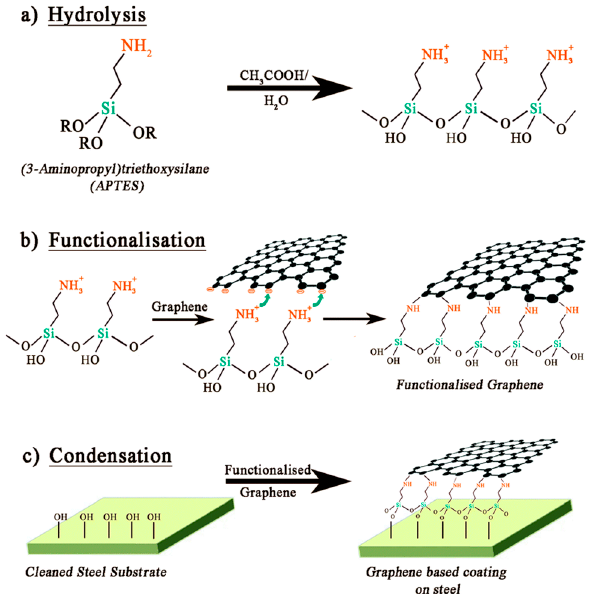
Figure 12. Schematic diagram of graphene functionalization: ( a ) APTES hydrolysis; ( b ) graphene functionalization; ( c ) coated substrate (i.e., mild steel) with functionalized graphene. Reproduced from ref. [160] with permission from The Royal Society of Chemistry.